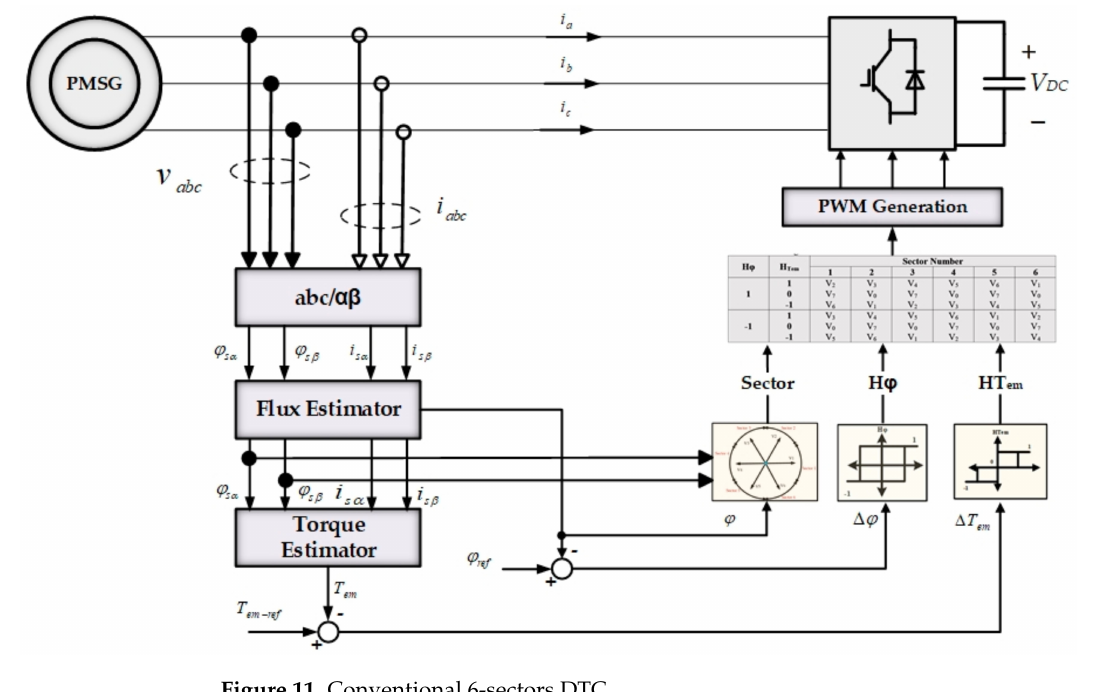
Figure 11. Conventional 6-sectors DTC.